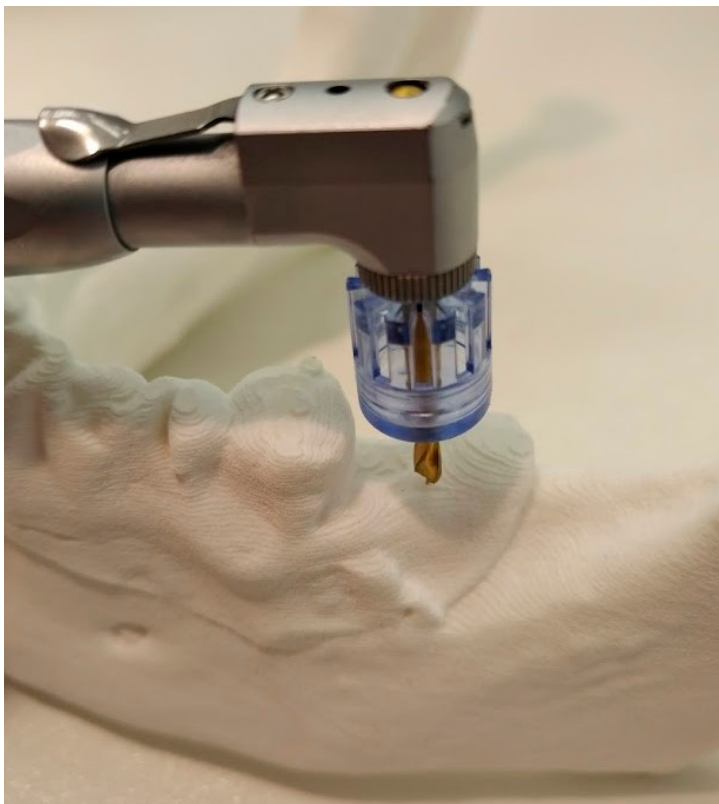
Figure 4. Drilling at site 47 with reference point of sleeve at pin in site 46.